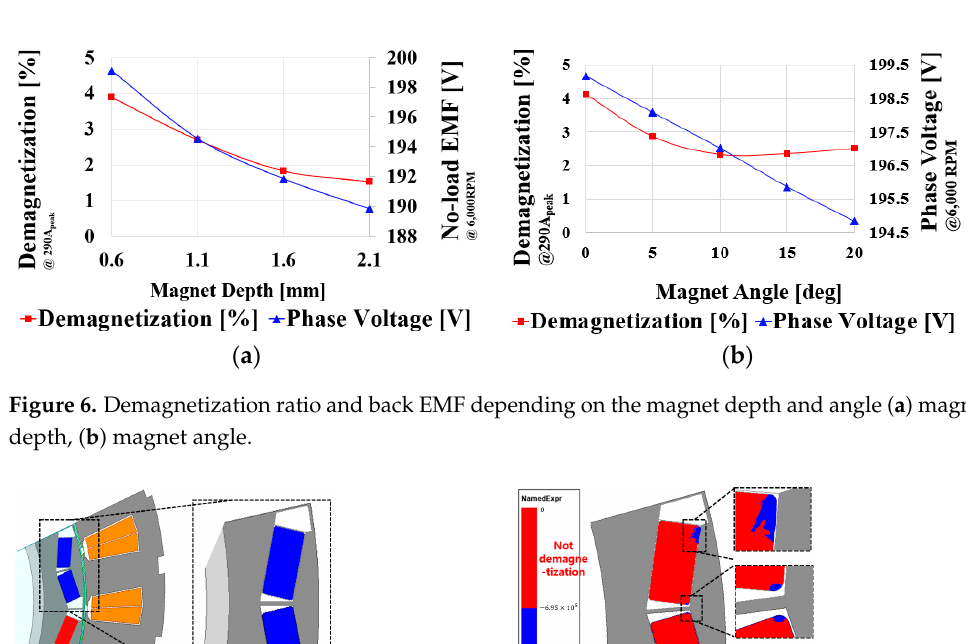
( b ) Figure 4. Irreversible demagnetization area obtained on inserting two magnets into a conventional model: ( a ) NdFeB magnet inserted, ( b ) Dy − free NdFeB magnet inserted. 2.2. Rotor Design Resistant to Irreversible Demagnetization The armature reaction magnetic flux generated by the stator winding acts as a reverse magnetic field in the direction opposite to the main flux from the permanent magnet. Therefore, as the reverse magnetic field generated by the armature reaction hits the mag- net strongly, the magnet loses its properties. This is called irreversible demagnetization. Irreversible demagnetization can be controlled depending on the insertion type of the magnet. Figure 5 shows the magnetic flux density vector diagrams for the bar and V- shaped types. ( a ) ( b ) Figure 5. Magnetic flux density plot depending on magnet type: ( a ) Bar type, ( b ) V-shaped type. The existing bar type is vulnerable to irreversible demagnetization because the mag- netic path of the demagnetization magnetic flux emitted by the stator winding is not se-